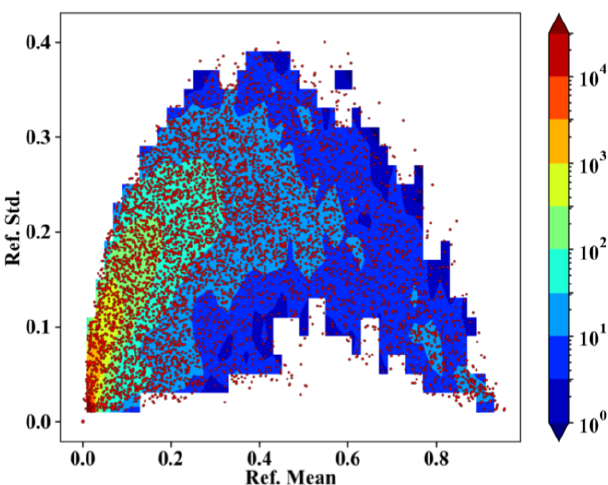
Figure 9. A distribution of the standard deviation of reflectance (Ref std ) vs. the mean of reflectance (Ref mean ) for the gridded and sampled data set. Each red scatter dot represents a 64 × 64 re- flectance image belonging to the consolidated gridded and sampled data set consisting of the 1 × 1, 2 × 2, and 4 × 4 coarsening factor data